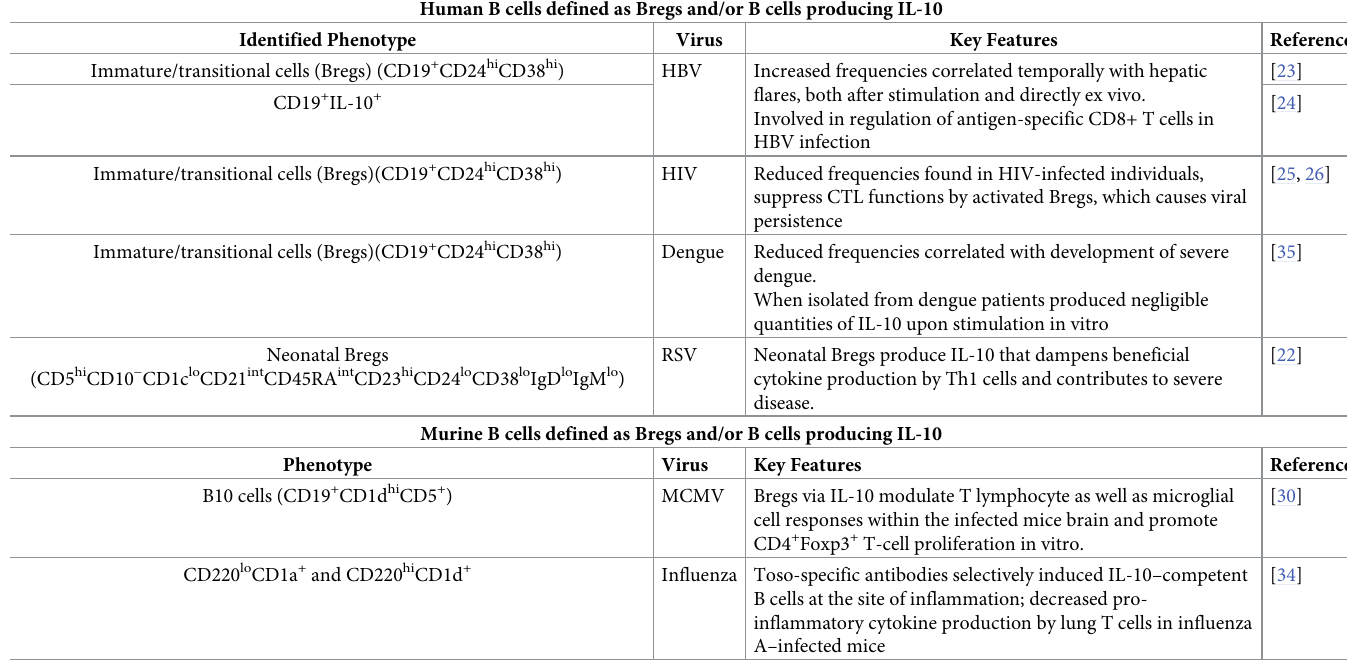
Table 1. This table shows currently described subsets of Bregs and IL-10–producing B cells during viral infections in humans and mice. Human B cells defined as Bregs and/or B cells producing